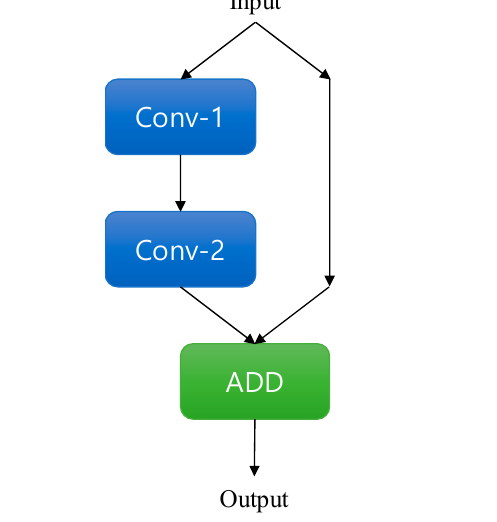
Figure 10. ResBlock structure. ResBlock consists of two convolution layers: the output of the ResBlock is the sum of the input feature and the output of the last convolution layer. Table 1. Layer configuration of CNN.